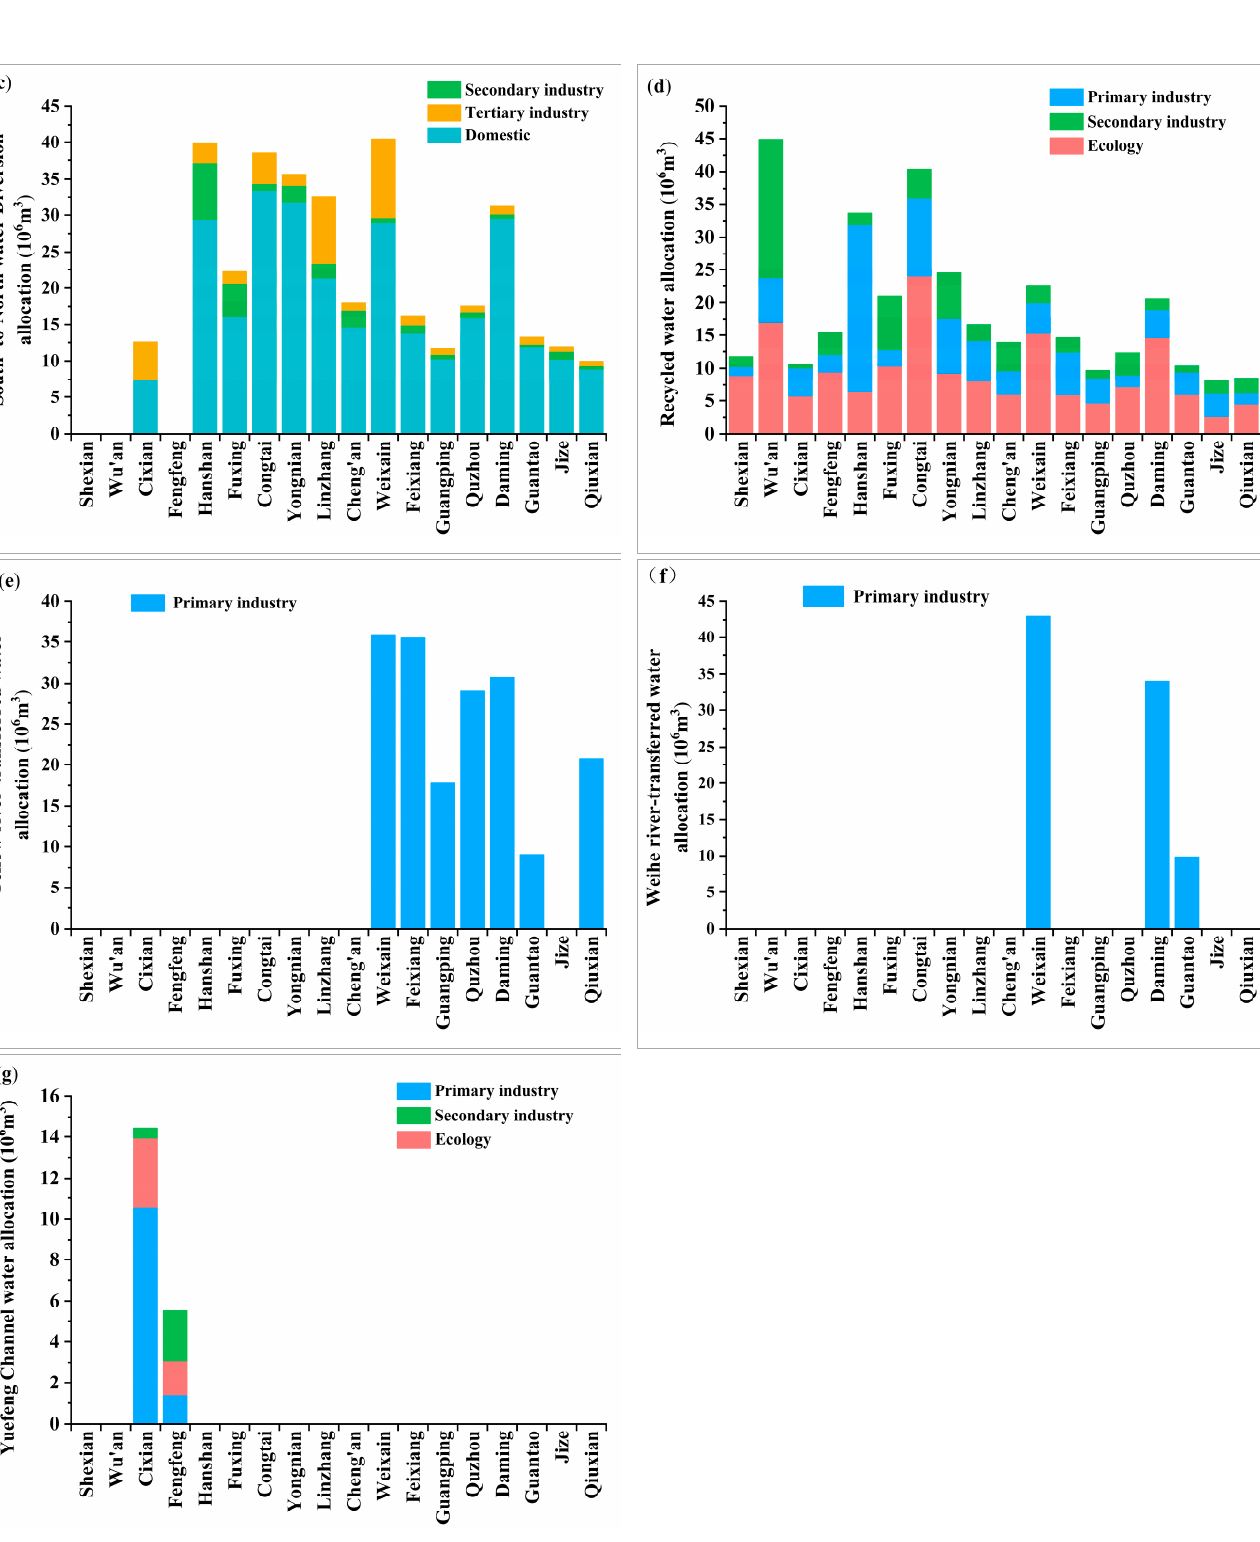
Figure 6. Allocation of different water supply sources in Handan. ( a ) Groundwater, ( b ) Reservoir water, ( c ) South-to-North Water Diversion, ( d ) Recycled water, ( e ) Yellow river-transferred water, ( f ) Weihe river-transferred water, and ( g ) Yuefeng channel water.